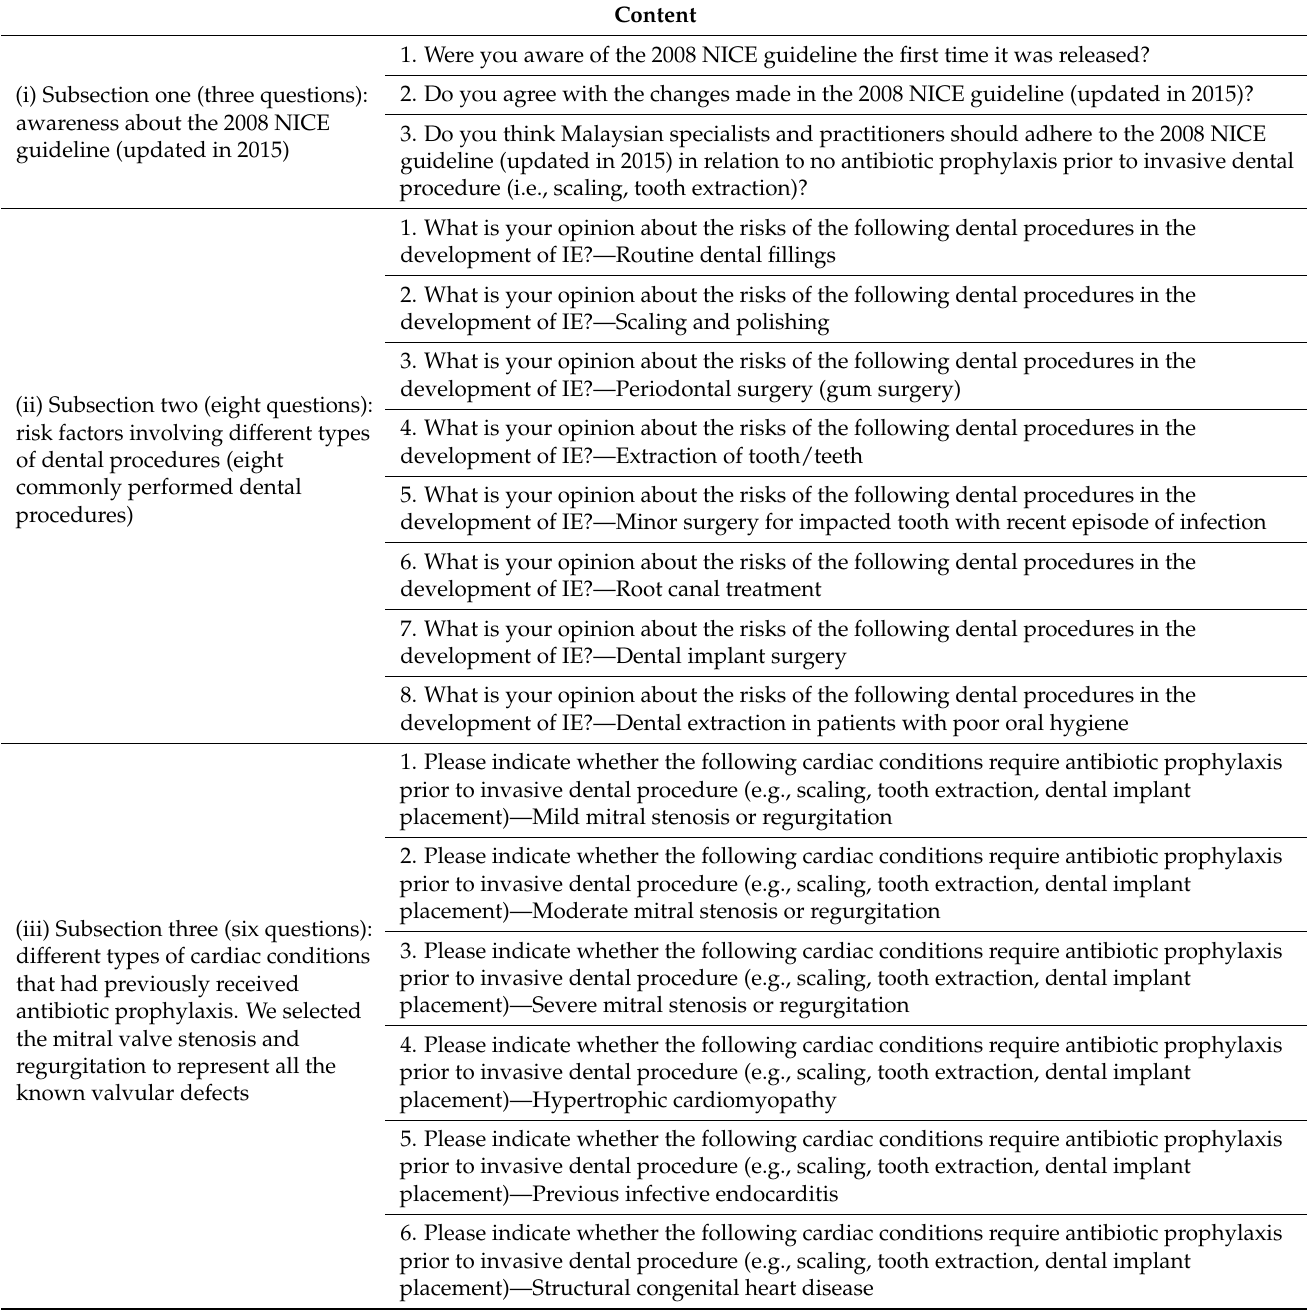
Table 1. Questions in section two of the